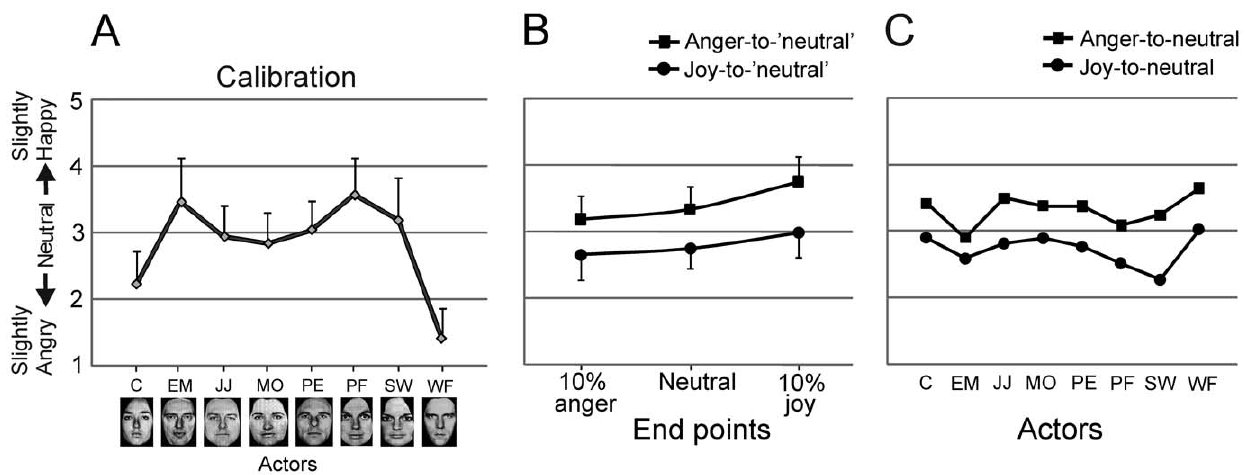
Figure 2. Results of Experiment 1. (A) Ratings on the 5-point scale (y-axis) for the neutral expressions of the eight actors (x-axis) in the calibration phase. Error bars indicate + 1SD. (B) Ratings on the same scale for the expressions depicted on the last frame of the joy-to-‘neutral’ and anger-to- ‘neutral’ videos. The sequences ended at 10% anger, neutral or 10% joy (x-axis). Error bars indicate 1SD. (C) Ratings for exclusively the neutral expressions at the end of the joy- and anger-videos for each of the eight actors to illustrate response consistency across actors.